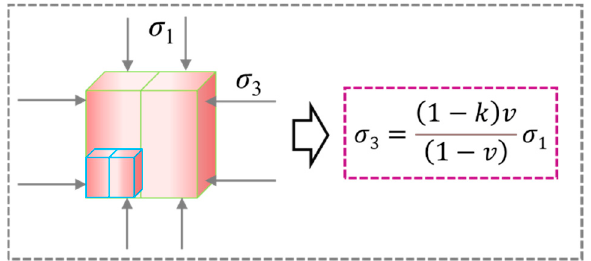
Figure 11. Schematic diagram of friction effect at the end of backfills.